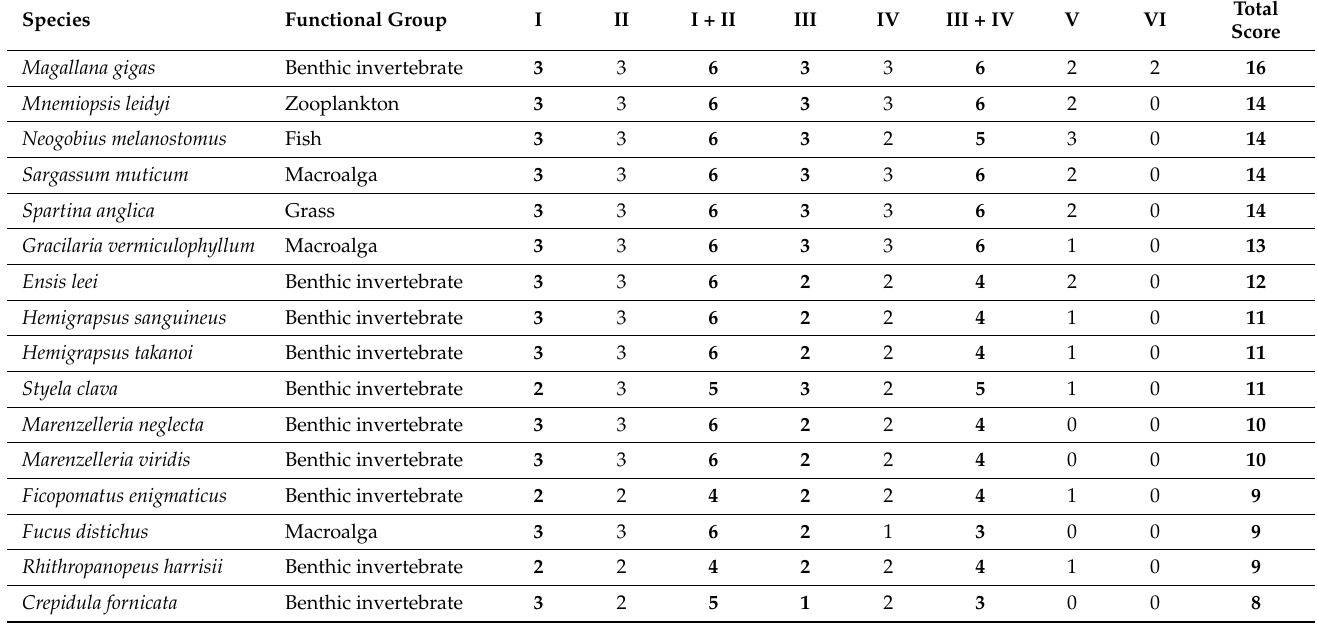
Table 1. Expert scores for marine NIS occurring in Danish waters. I—dispersal potential; II— conservation value of habitat; III—impact on native species; IV—impact on ecosystem functions; V —